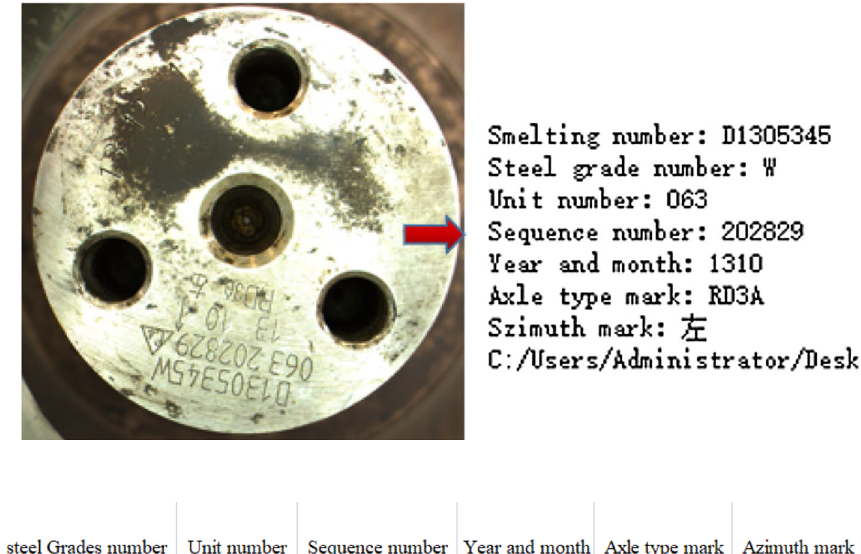
Fig. 21 Identification results